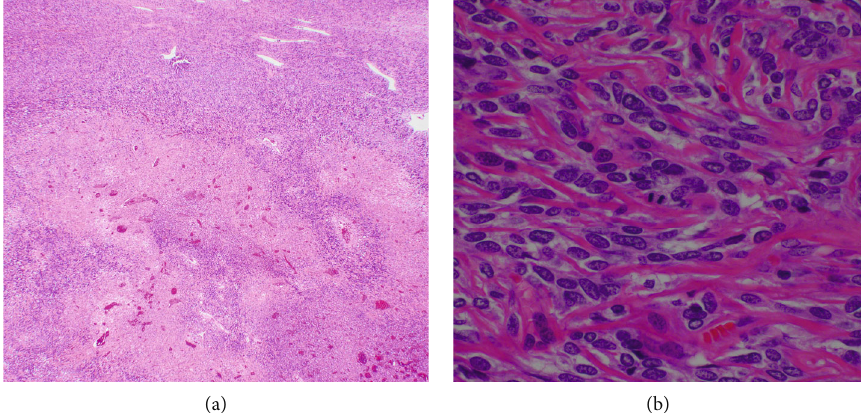
Figure 3: (a, b) The tumor was composed of haphazardly arranged spindle to ovoid cells with indistinct, pale cytoplasm, dense hyalinized collagenous stroma, frequent mitoses, necrosis, and characteristic staghorn-shaped blood vessels ((a) (40x) and (b) (400x)).